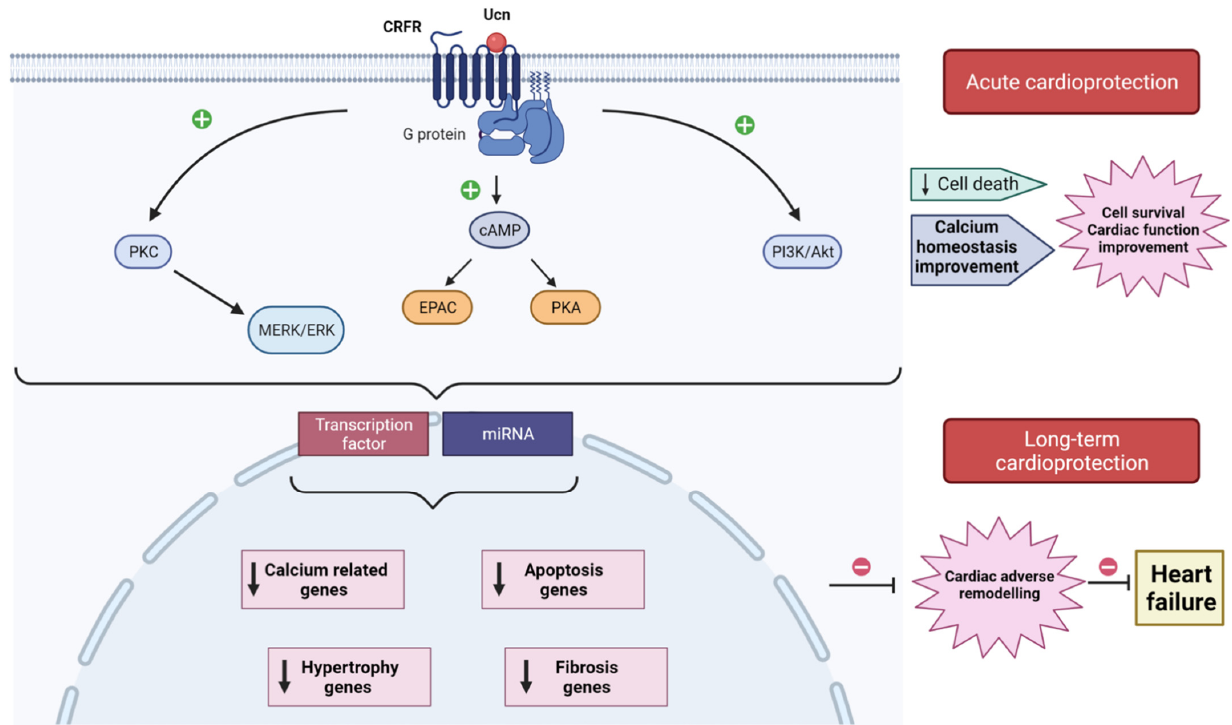
Figure 1. Schematic model illustrating acute and long-term cardioprotection afforded by urocortin (Ucn) from I/R injuries. In heart, Ucn binds to CRFR2, which interacts with G-proteins activating different signaling pathways (PKC-MERK/ERK; cAMP-EPAC/PKA; PI3K/Akt) that acutely decrease cell death, improve Ca 2+ handling, enhance cell survival, and improve cardiac function. Ucn also activates transcription factors and stimulates miRNAs, release which regulates the expression of genes related to apoptosis, fibrosis, hypertrophy, and Ca 2+ homeostasis. The downregulation of these genes prevents the development of adverse cardiac remodeling, avoiding its progress toward heart failure.